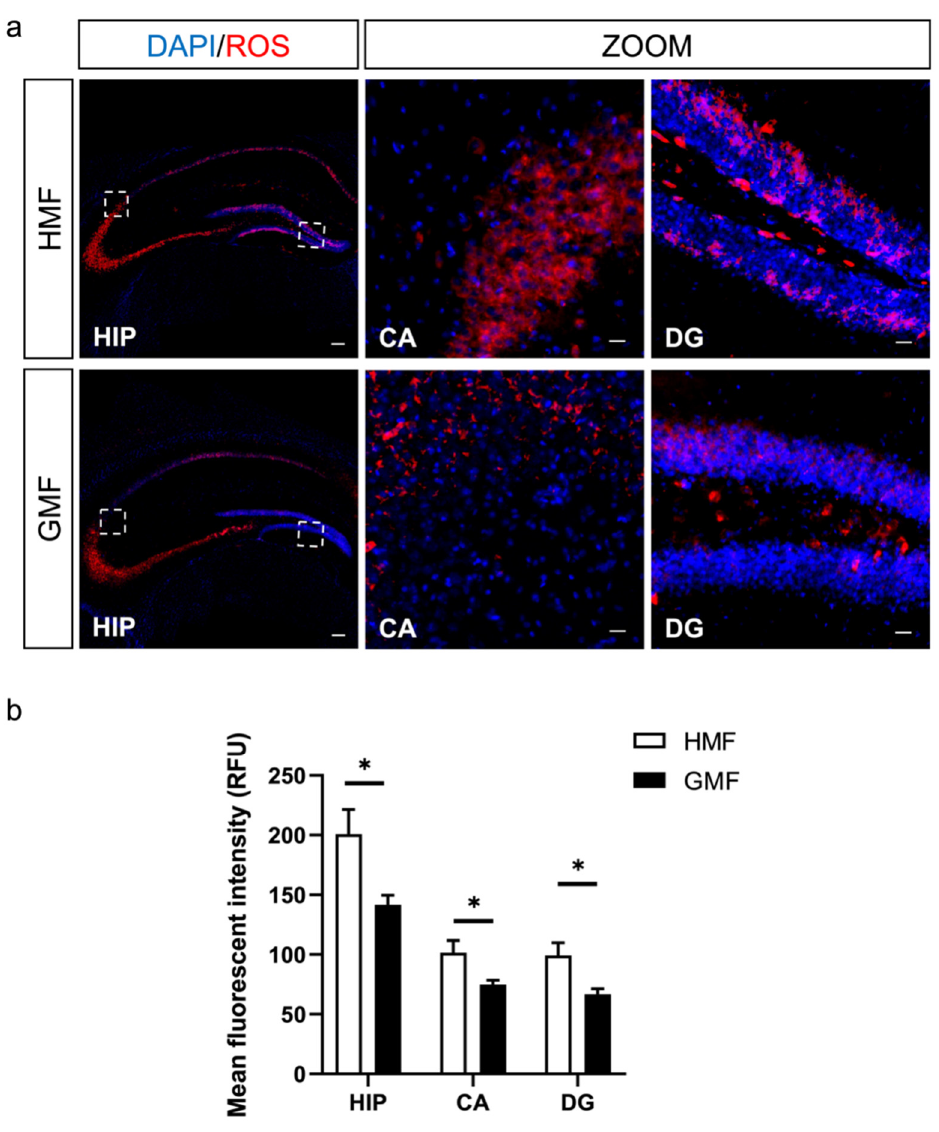
Figure 2. The effects of HMF treatment on ROS levels in hippocampus. ( a ) Representative images of hydroethidine fluorescence (red) in the dentate gyrus (DG) and cornu ammonis (CA) of the hippocampus (HIP) in GMF- and HMF-exposed mice. DAPI staining (blue) was used for distinguishing the different hippocampal regions in brain sections. HIP Scale bar = 500 μ m, CA/DG Scale bar = 100 μ m. ( b ) Quantitative analyses of hydroethidine fluorescence intensity (ROS) levels of neural cells in the dentate gyrus, cornu ammonis areas, and both hippocampus of GMF- and HMF-exposed mice. n = 4 mice. Data are presented as mean ± SEM. * p < 0.05. HIP: p = 0.0374, unpaired t -test. CA: p = 0.0481, unpaired t -test. DG: p = 0.0301, unpaired t -test.